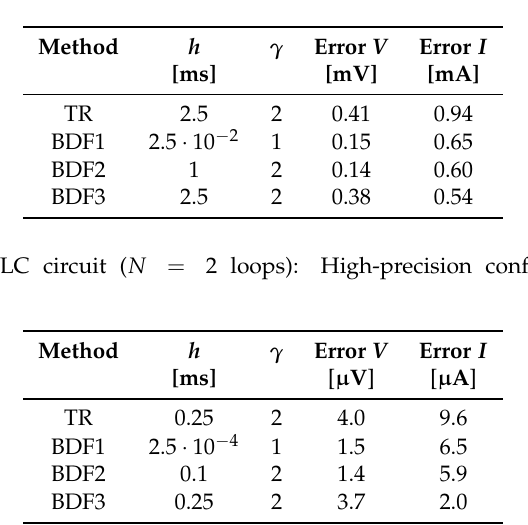
Table 10. Scalable RLC circuit ( N = 2 loops): Low-precision configuration of the DAE integration methods.